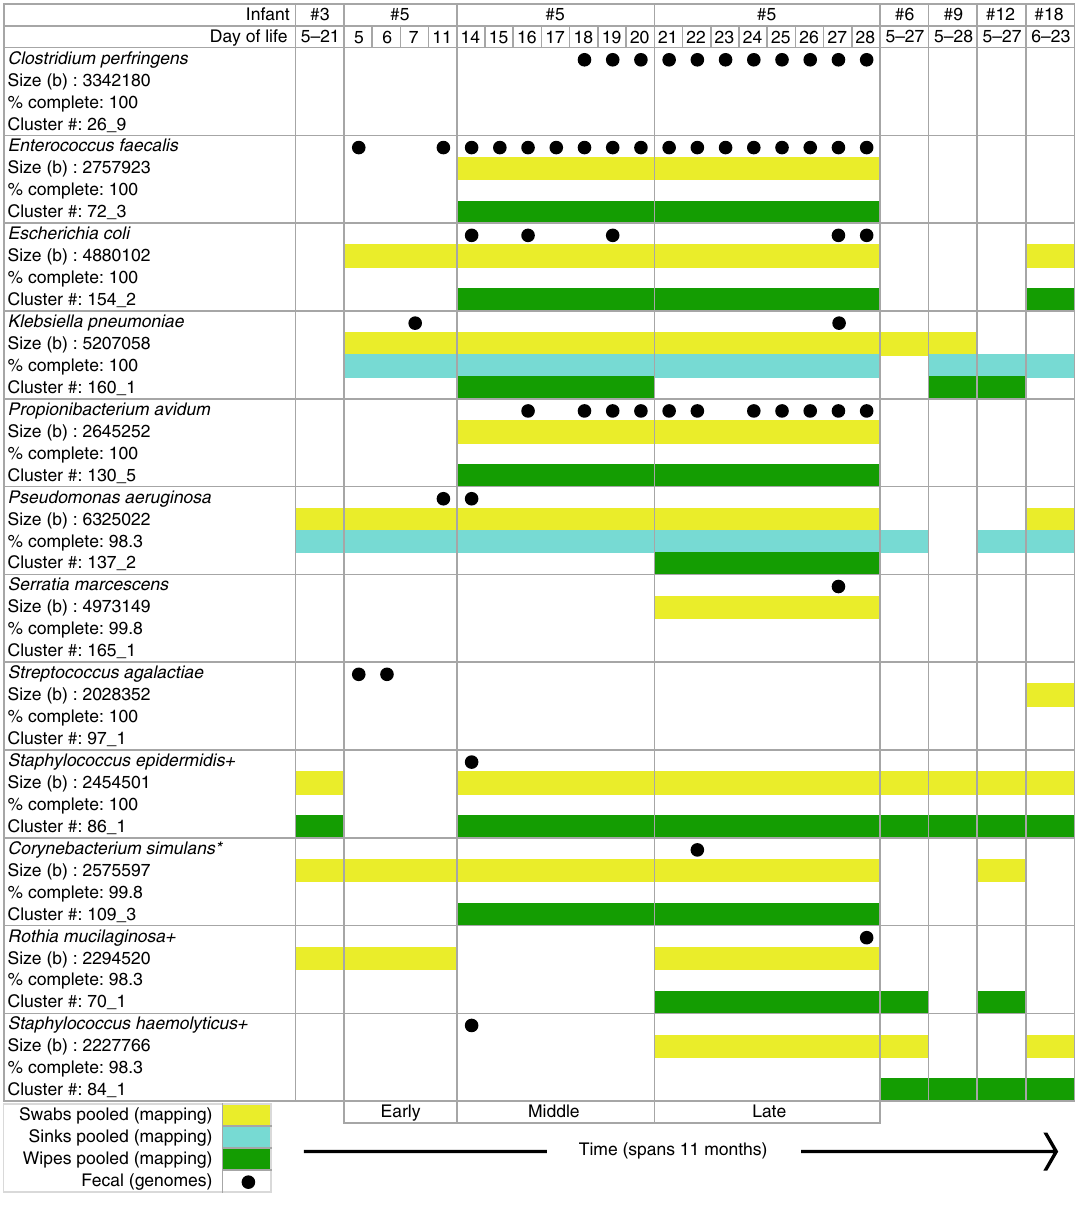
Fig. 3 Strains associated with infant 5 also occurred in this infant ’ s room and in rooms of previously and subsequently hospitalized infants. Detection in swabs from frequently touched surfaces (yellow), sinks (blue), and wipes from other surfaces (green). The results are shown in chronological order from left to right. Genomes recovered from speci fi c days of life from infant 5 ’ s samples are indicated by black dots. Room detection of strains is indicated by a colored bar because room samples from one environment type were pooled, either by infant or for three time periods for infant